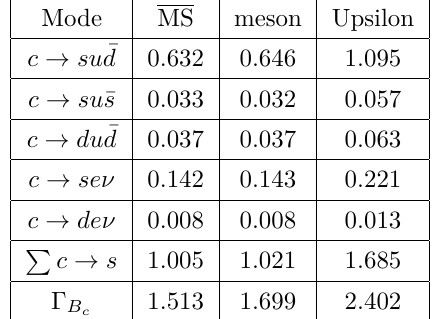
Table 4 . Results for the partial decay rates in ps − 1 including the effects of non-vanishing strange quark mass in all three schemes: MS, meson and Upsilon schemes. The “Total” row gives the full decay